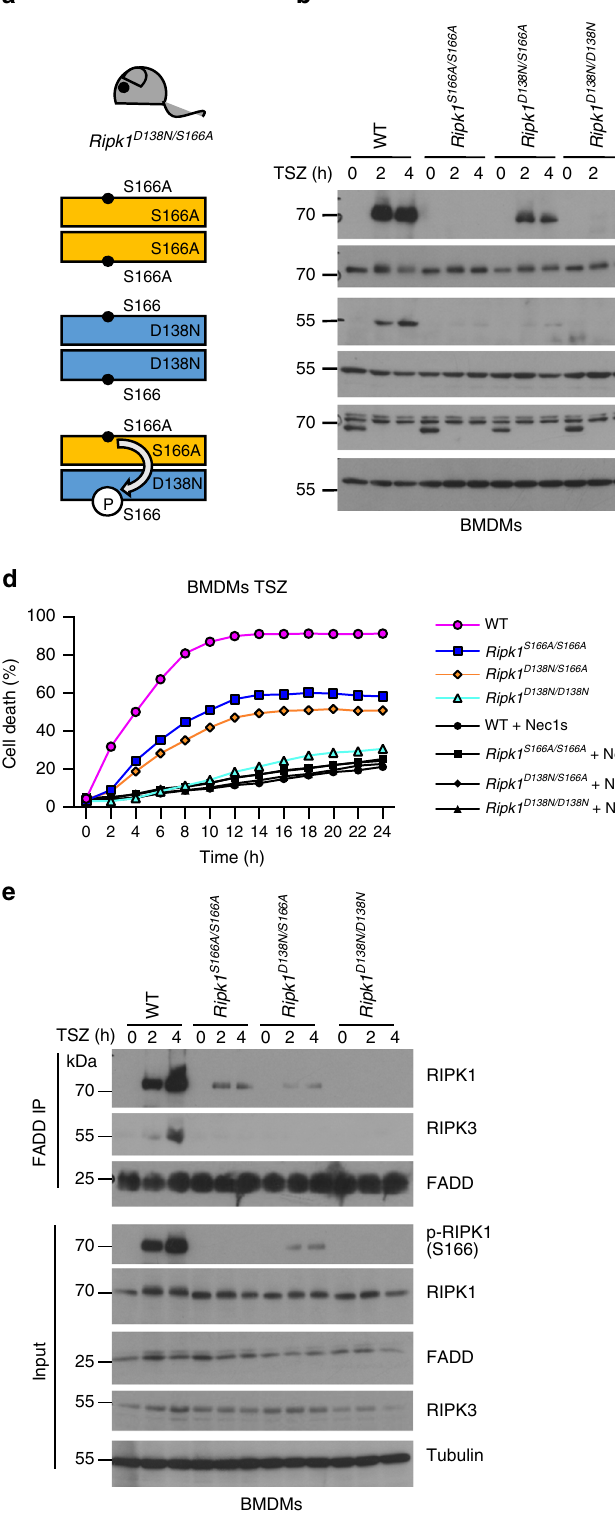
rehydrated and heat-induced antigen retrieval was performed in Tris-citrate buffer. Sections were incubated with primary antibodies against cleaved caspase-3